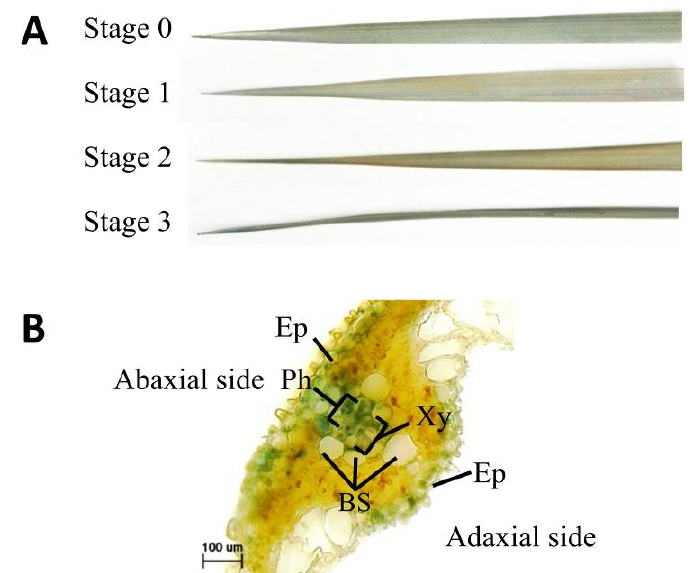
Figure 5. Trypan blue staining of dead cells in F 1 leaves. ( A ) Stained leaves from each yellowing stage. ( B ) Transverse section of a stained Stage-3 leaf. Scale bar indicates 100 µm. Xy: Xylem; Ph: Phloem; Ep: Epidermal cell; BS: Bundle sheath cell.